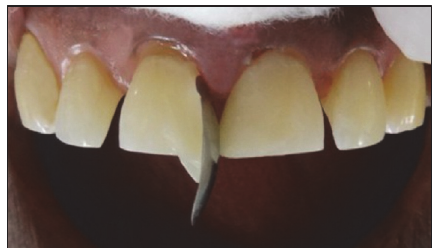
Figure 5: Palodent matrix and mylar strip were applied for restora- tion of 21.